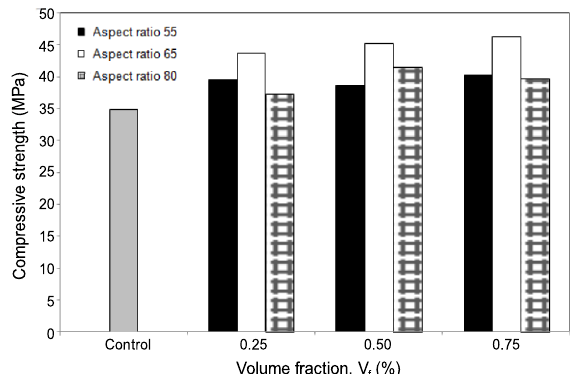
Fig. 4. Effect of volume fraction and aspect ratio on compressive